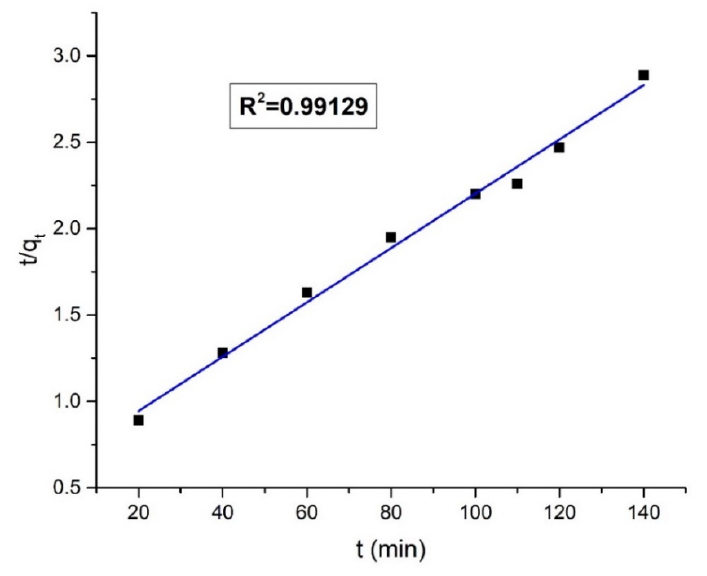
Figure 17. Pseudo-second-order kinetic model plot.